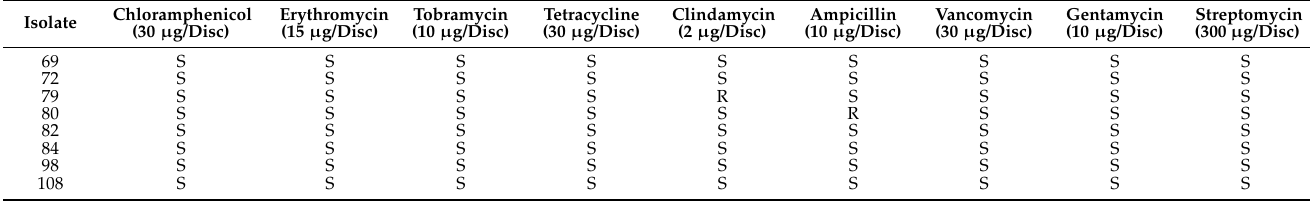
Table 1. Results of antibiotic susceptibility profile of lactic acid bacteria isolates from xique-xique cladodes and fruit. Isolate